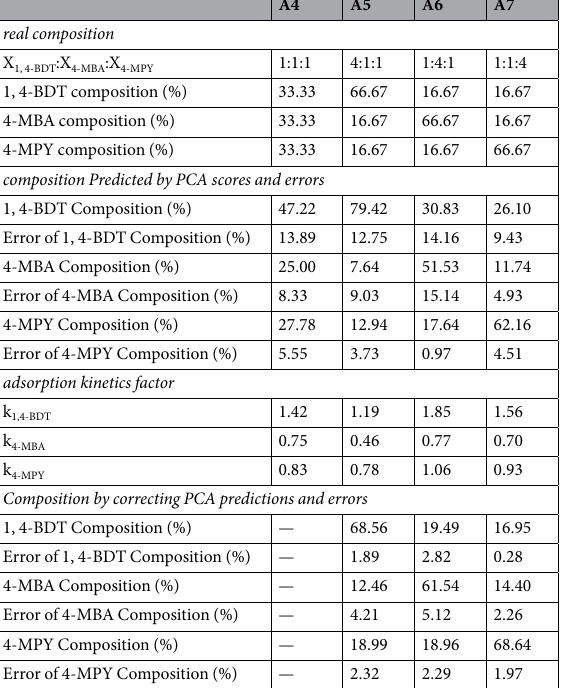
loading matrix and we obtained PCs scores for the ternary mixtures which were plotted in Fig. 4b. It is observed that two PCs (PC1 and PC2) accounts for ~99.71% of the variance. It is obvious that the PCA scores also gathered together. We averaged PC1 and PC2 scores of 1, 4-BDT, 4-MPY, 4-MBA, and their ternary mixtures, respectively. And we predicted the composition of each sample by using average PC1 and PC2 scores as shown in Table 2. However, there still exist errors between predicted compositions and real values due to the difference in adsorp- tion kinetics of each component, e.g., 13.89% for 1,4-BDT in A4 samples, 12.75% for 1,4-BDT in A5 samples, 15.14% for 4-MBA in A6 samples. Hence, we calculated adsorption kinetics factor for each component in the similar way as we did for binary mixtures (presented in Table 2). Result indicates that the adsorption kinetics factors for a specific component show minor changes. Hence, we obtained other samples’ compositions by cor- recting PCA predictions using adsorption kinetics factors of sample A4, e.g., 1.42 for adsorption kinetics factor of 1,4-BDT, 0.75 for adsorption kinetics factor of 4-MBA, and 0.83 for adsorption kinetics factor of 4-MPY. It is noticeable that the predicted compositions shown in Table 2 are in good agreement with the real ones, i.e., the errors are around and less than 5%. In addition, we obtained composition of samples (spots plotted in Fig. 4b) by PCA prediction. Plot of real composition in solution versus composition predicted by PCA was presented in Fig. 4c. For comparison, corrected PCA predictions according to adsorption kinetics factor of sample A4 were plotted in Fig. 4d. Figure 4d illustrates that the results obtained by correcting PCA predictions using adsorption kinetic factors of sample A4 are located around real values in solution, which proves the accuracy of prediction. On the other hand, results neglecting adsorption kinetics difference of each molecule are far away from the real values in solution. This method of predicting real compositions in solution was also carried out for 1, 4-BDT, 2-NaT, 4-MBA, 4-MPY, and their quadruple mixtures. Table S1 (provided in Supporting Information) summarizes real compo- sition in solution, composition predicted by PCA, adsorption kinetic factor for each component, and corrected PCA prediction of quadruple samples. Figure 5a shows their quadruple mixtures’ SERS spectra. One can observe that SERS spectra were roughly similar. Hence, we perform PCA for 1, 4-BDT, 2-NaT, 4-MPY, and 4-MBA mol- ecules to get loading matrix. Subsequently, PCA for the SERS spectra of quadruple mixture samples using the loading matrix were performed, and the average PCs scores of each samples were presented in Fig. 5b. It shows that three PCs (PC1, PC2 and PC3) accounts for around 99.55% of the variance. Compositions of mixture sam- ples (presented in Table S1) were calculated by PCA using the average PCs scores mentioned above. Similarly, composition errors can be observed between values calculated by PCA and the real ones in solution due to mol- ecules’ different adsorption kinetics, e.g., 12.91% for 4-MPY in sample A5 and 17.95% for 4-MBA in sample A8. We obtained adsorption kinetic factor of each component in all quaternary samples the way mentioned previ- ously and it shows minor changes. Then, the adsorption kinetics factor for each component of sample A5 was treated as the reference and corrected predictions were presented in Table S1. The errors are around and less than 6%. Furthermore, we corrected PCA predictions of every quadruple mixtures spectrum collected by using the